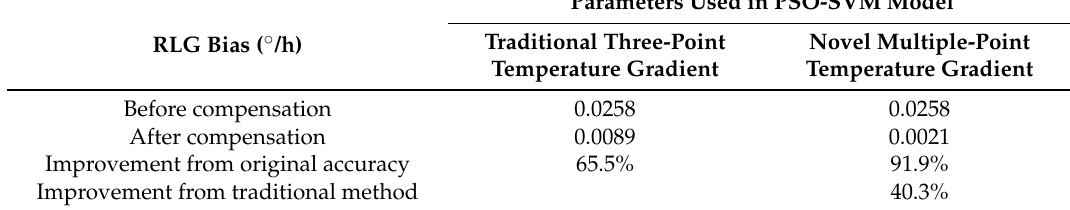
Table 4. RLG bias compensation effect of particle swarm optimization-support vector machine (PSO-SVM) model using different temperature gradient algorithms in temperature variation rate experiment.